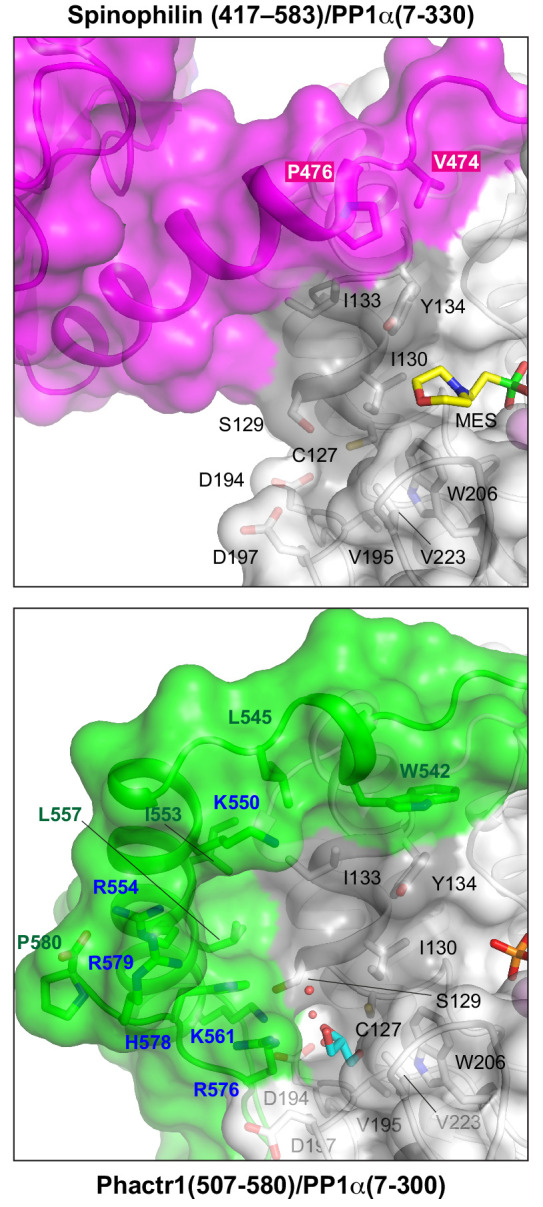
Spinophilin remodels the PP1 hydrophobic groove in a different way to Phactr1.Top, the spinophilin/PP1 complex shown in surface representation (magenta, spinophilin; grey, PP1); bottom, the analogous region of the Phactr1/PP1 complex in the same orientation from Figure 2B, repeated for comparison.